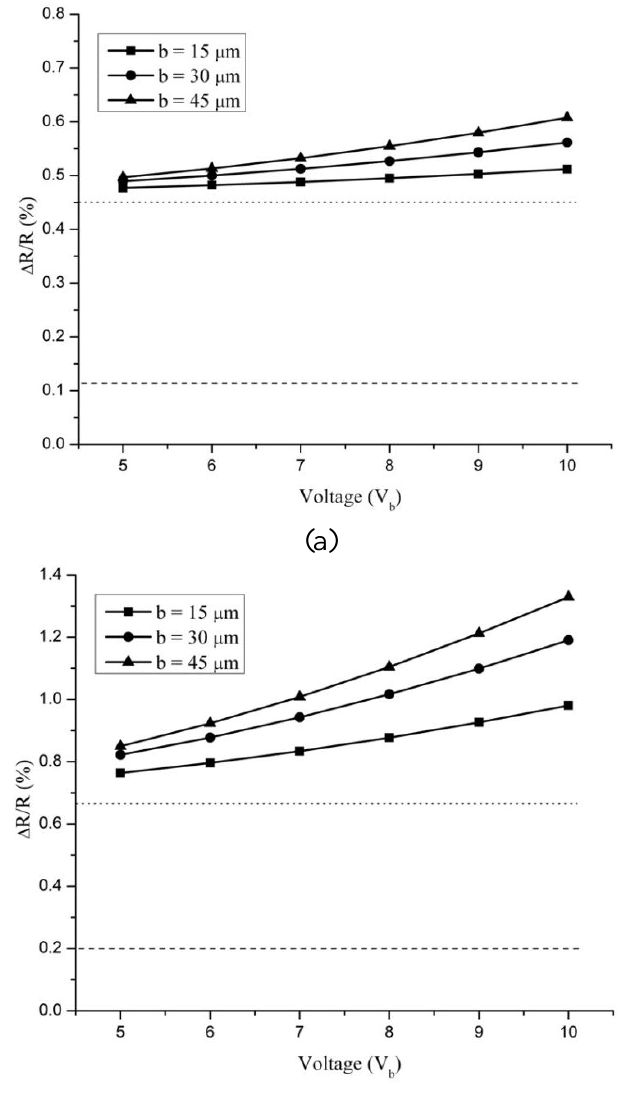
Figure 6. Total thermal sensitivity of silicon (a) and silicon dioxide (b)